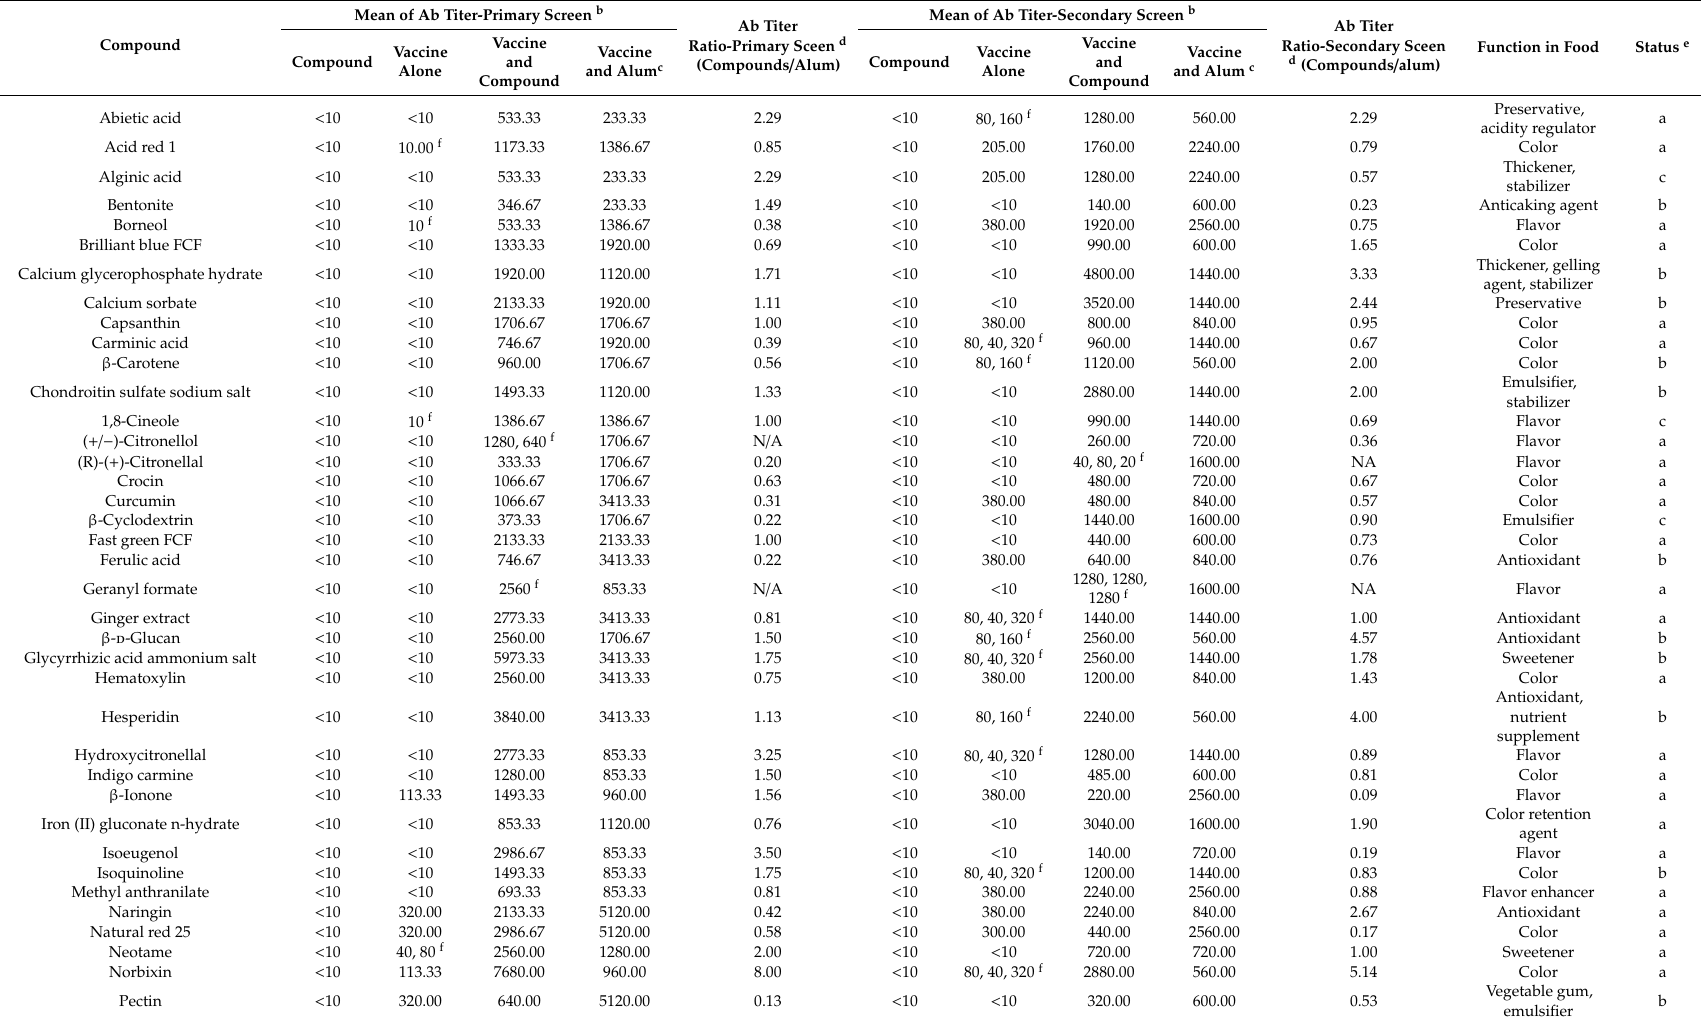
Table 1. Virus-specific antibody titers in sera from immunized mice for the 59 hit compounds identified in the primary screen a .